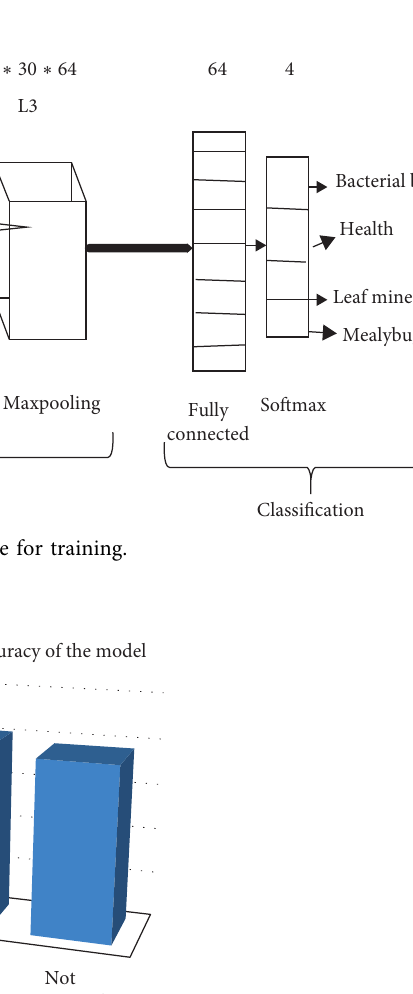
Figure 5: Cotton leaf diseases and pests recognition model process.